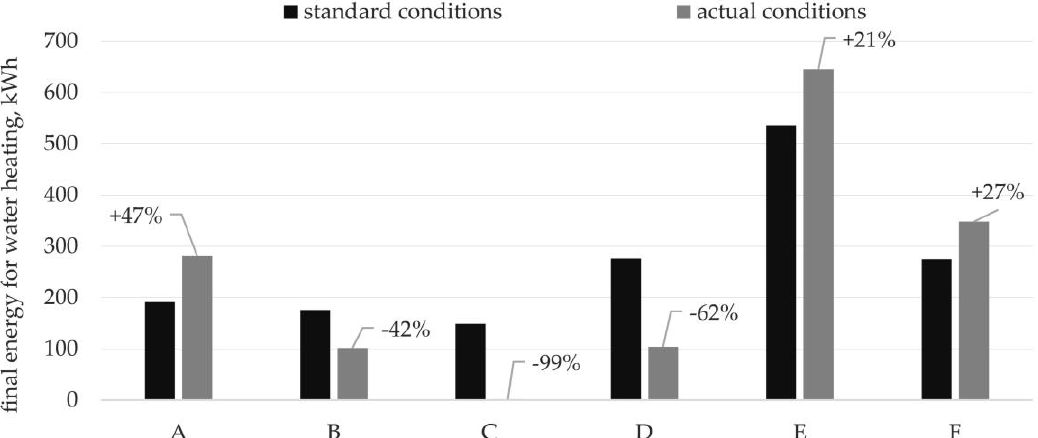
Figure 4. Actual and standard final energy consumption for DHW (domestic hot water) preparation for time period from 14 January to 9 March 2020 showing the energy performance gap for water heating ( EPG w ).